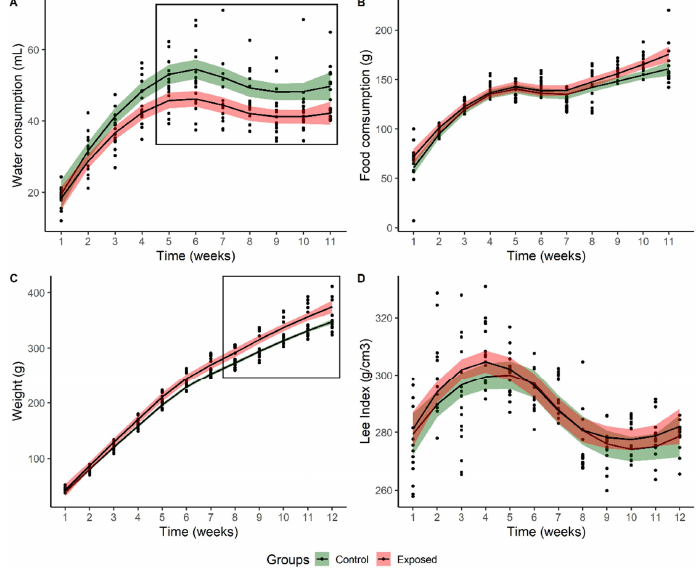
Figure 2. Variation in biometric parameters for Wistar rats exposed to no contaminated water (control) and water contaminated with DDD + DDE (0.002 mg.L − 1 + 0.005 mg.L − 1 ): ( A ) water consumption; ( B ) food consumption; ( C ) body weight; ( D ) Lee index. Boxes highlight signi fi cant di ff erences between treatments. The total body weight gain for the exposure group was signi fi cantly higher (t 14 = − 2.34, p = 0.046), despite the body weight gain rate not showing signi fi cant di ff erences between groups (t 14 = − 0.12; p = 0.910). Total food consumption (t 14 = − 1.97; p = 0.069), feed e ffi ciency (t 14 = 1.45, p = 0.170) and body weight gain per caloric intake (t 14 = 1.45, p = 0.170; Table 1) were similar between groups. Table 1. Biometric evaluation results. Results expressed in mean ± standard error; * denotes signi fi cant di ff erence from the control ( p < 0.05). Evaluation